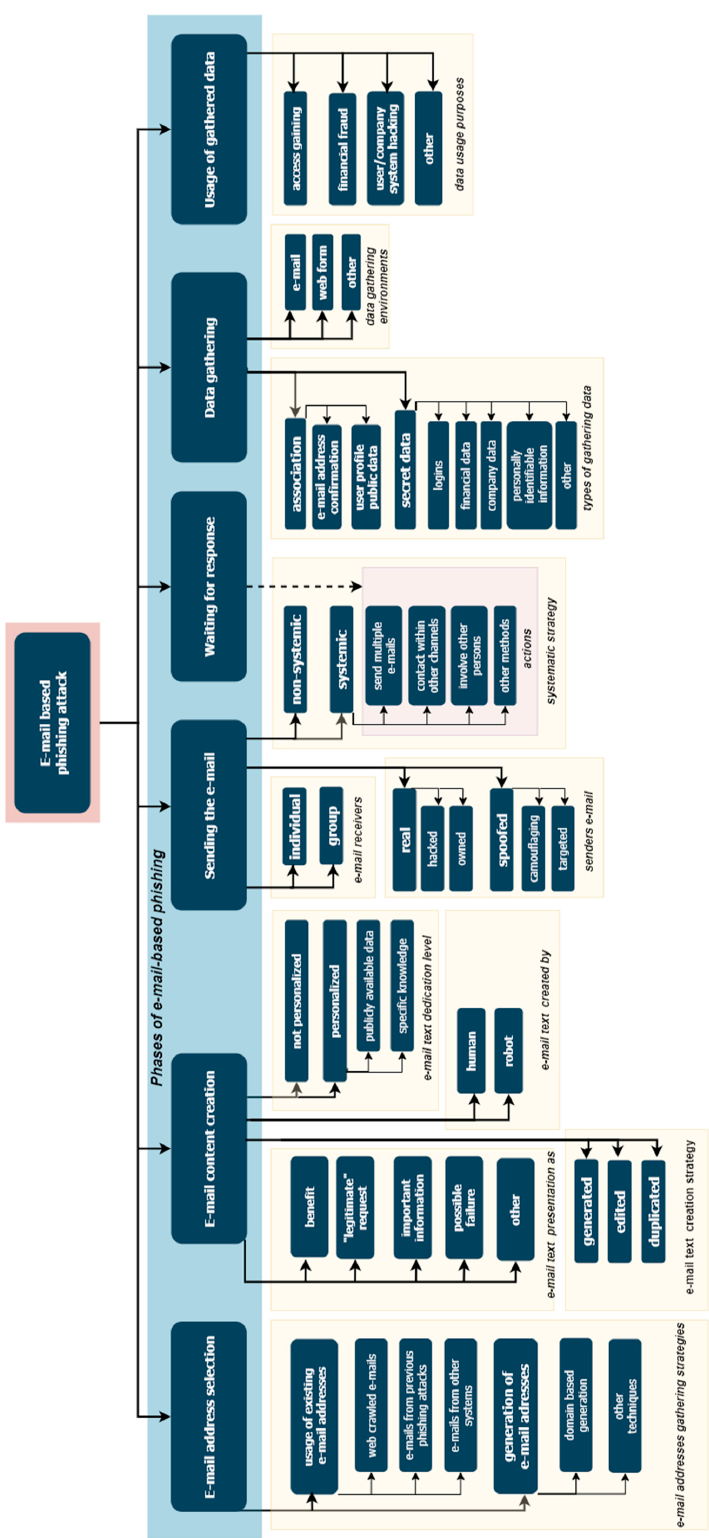
Figure 4. Structure of the presented e-mail-based phishing attack taxonomy.